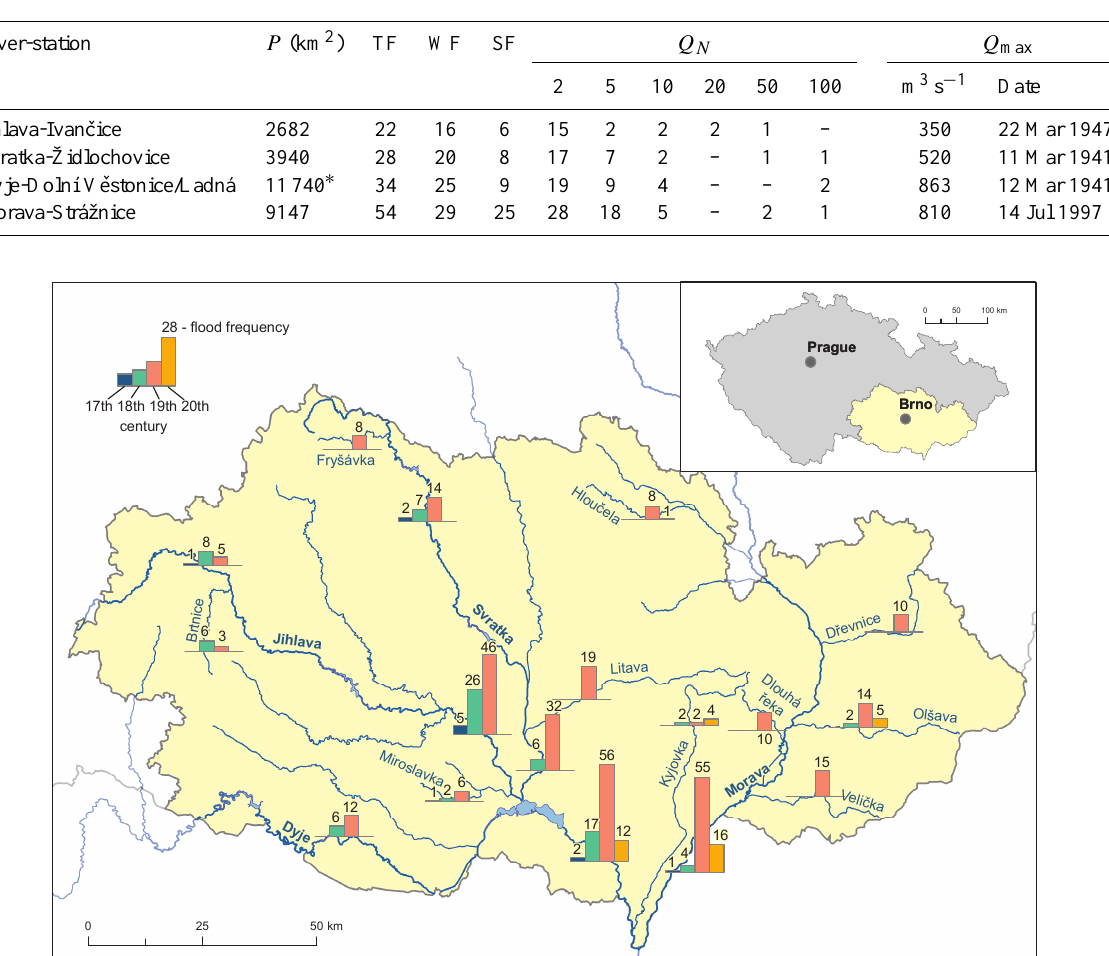
Table 1. Comparison of floods with peak discharges Q k ≥ Q 2 for four selected South Moravian rivers in 1931–2010: P – catchment area above the station; TF – total number of floods; WF (SF) – number of winter (summer) floods; Q N – number of floods with a recurrence interval of N = 2, 5, 10, 20, 50 and 100 years; Q max – absolute peak discharge and date of its occurrence. The Ladná station replaced Dolní Vˇestonice in 1987; ∗ – P for the Ladná station is 12280km 2 .